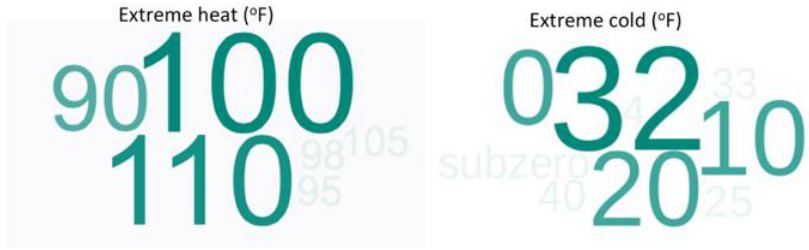
Figure A2. Thresholds demarking adverse temperatures based on survey responses. The size of the number is proportional to the number of times it was referenced. From Figure 3 of McPherson and Mullens (2017).